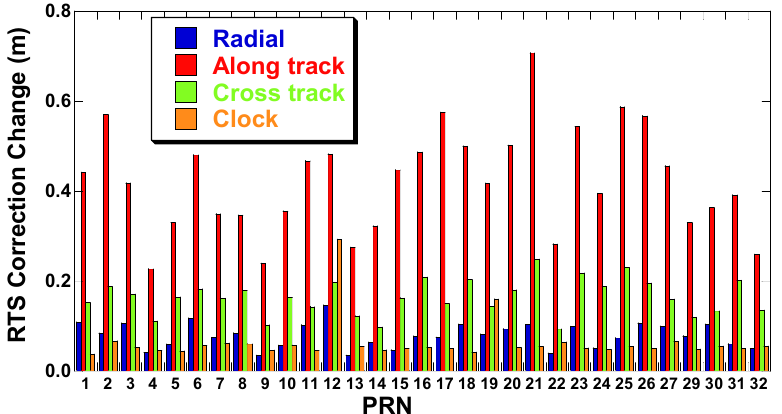
Figure 3. The magnitude of the RTS correction differences at IOD changes (GPS satellites, 28 Sep- tember–2 October 2022).